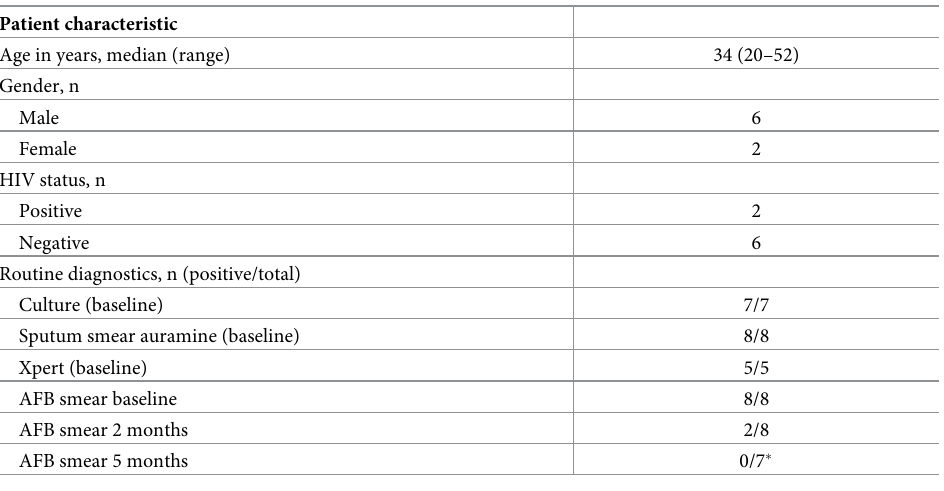
Table 1. Characteristics of the study participants (n = 8).